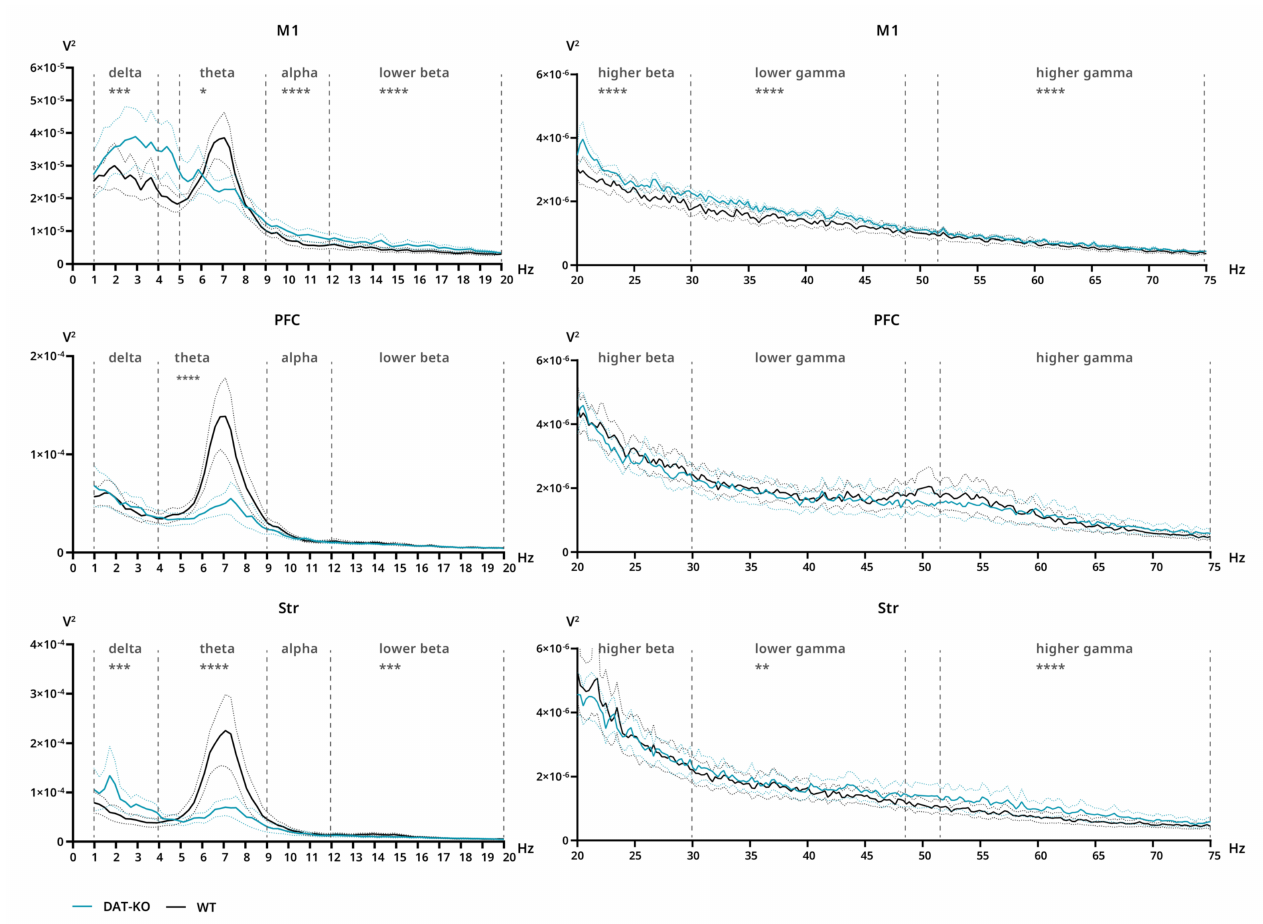
Figure 4. Power spectra of brain activity of DAT-KO (teal) and WT (black) rats recorded from motor cortex (M1), prefrontal cortex (PFC) and striatum (Str). 20–75 Hz range presented separately due to scale difference. Data are presented as mean (solid line) ± SEM (dotted line). Dashed lines represent electroencephalographic rhythms: delta (0.9–3 Hz), theta (4–8 Hz), alpha (9–11 Hz), lower beta (12–19 Hz), higher beta (20–29 Hz), lower gamma (30–48), higher gamma (52–74 Hz). The range of theta rhythm in M1 changed to 5–8 Hz. * p < 0.05; ** p < 0.01; *** p < 0.001; **** p < 0.0001; two-way